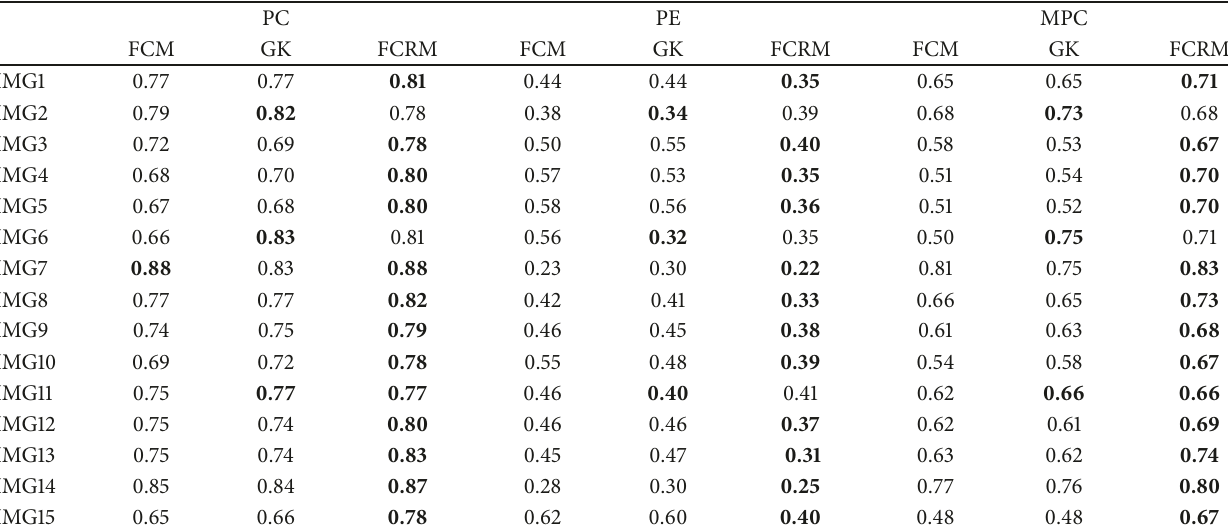
Table 5: FCM, GK, and FCRM using three different indices (PC, PE, and MPC).